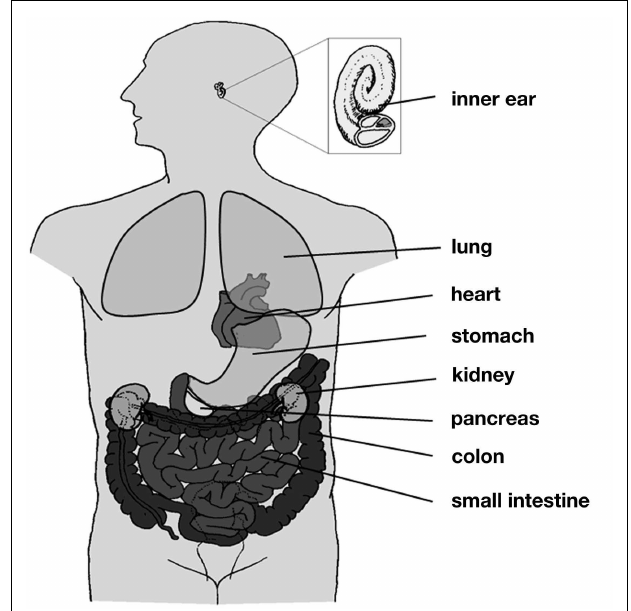
FIGURE 1 | Distribution of Kv7.1. Kv7.1 is expressed in several tissues throughout the human body, including heart, lung, inner ear, kidney, and the gastrointestinal